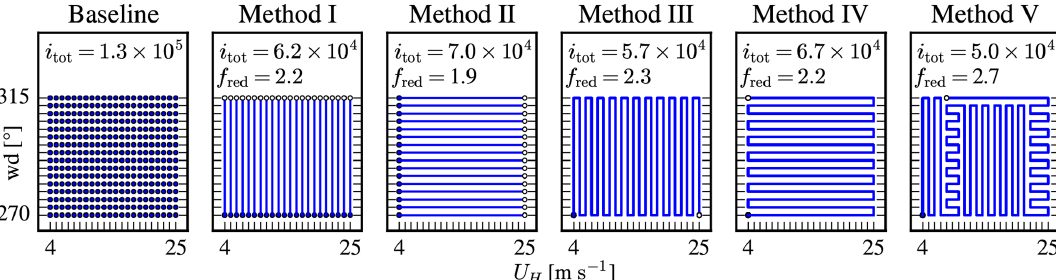
Figure 2. Parallel and sequential simulation methodologies to calculate the AEP using 22 wind speeds ( U H ) and 16 wind directions (wd). Filled and open circles represent the start and end flow cases. i tot is the number of iterations on the finest grid level and f red is the reduction of these iterations compared to baseline